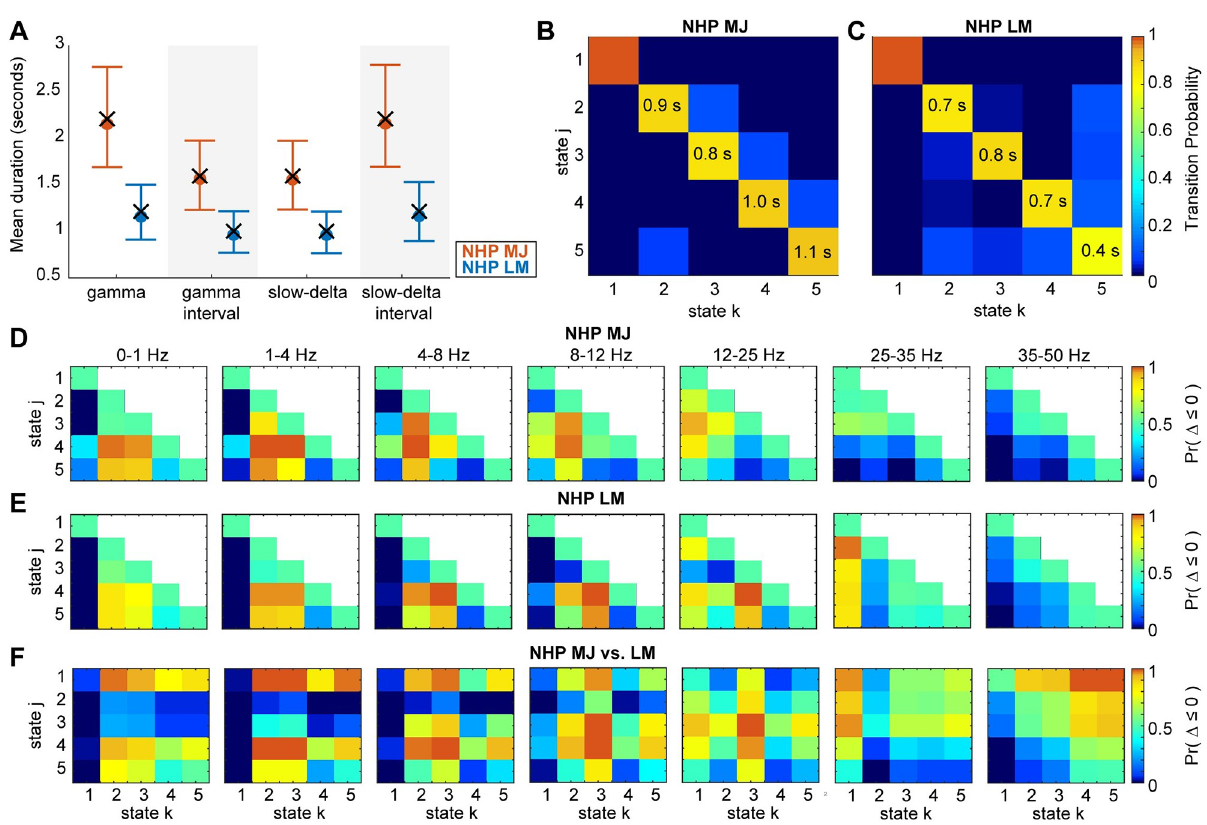
Fig 5. The estimated beta pdfs and transition matrices characterize the underlying dynamics of NHP LFP data following a 20 mg/kg bolus of ketamine. (A) Duration statistics corresponding to gamma and slow-delta activities in NHP MJ and NHP LM. For each subject, 4000 Markov sequences of length N = 2000 were simulated using the subject-specific estimated transition matrix. The mean duration and interval corresponding to the gamma and slow-delta activities were calculated for each realization of these sequences. Median and 95% confidence bounds across all the subject- specific simulated sequences are indicated in orange (NHP MJ) or blue (NHP LM). The mean duration and interval calculated from the estimated state trajectory (output of the Viterbi algorithm which uses the maximum likelihood beta-HMM parameters and the observations as input) are indicated by a cross ( × ) symbol. (B,C) The transition matrices for NHP MJ and NHP LM with expected state duration (in seconds) indicated on the diagonal for the states that occur following the ketamine bolus. (D-F) Heatmaps indicating the probability of the event that scaled power in state j (of NHP MJ in panels D and F, and of NHP LM in panel E) is less than or equal to the scaled power in state k (of NHP MJ in panel D, and of NHP LM in panels E and F) for each of the 7 frequency bands. Note that in panels D and E, the upper triangle (1 < j < k < 5), omitted to avoid redundancy, is equal to 1 minus the lower triangle (1 < k < j < 5). The color indicates Pr ( Δ � 0) which represents Pr ( X � 0), where X is a random variable characterized by state hj − X hk hj j ’s beta pdf in frequency band h and X hk is a random variable characterized by state k ’s beta pdf in the same frequency band h